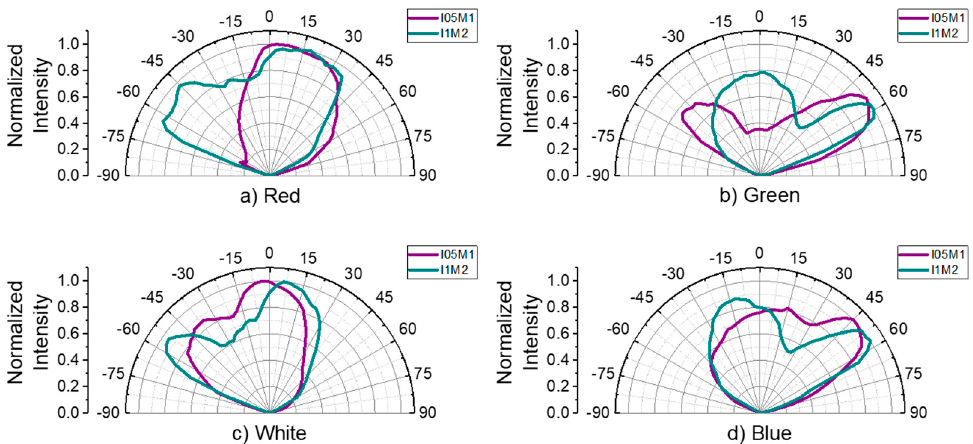
Figure 11. Polar radiation pattern of the two damaged samples for the four LED colors. Samples I05M1 and I1M2 were irradiated up to TIDs of 1.5 MGy and 2 MGy, respectively.